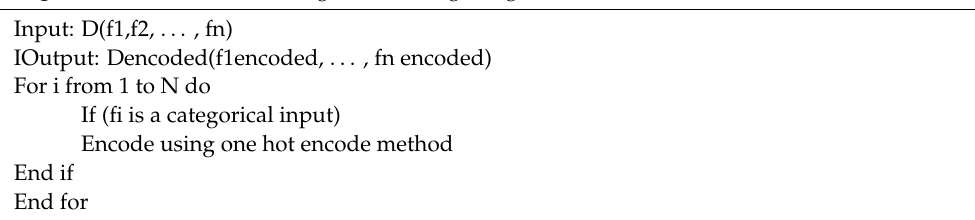
Algorithm 1: One-hot encoding for encoding categorical